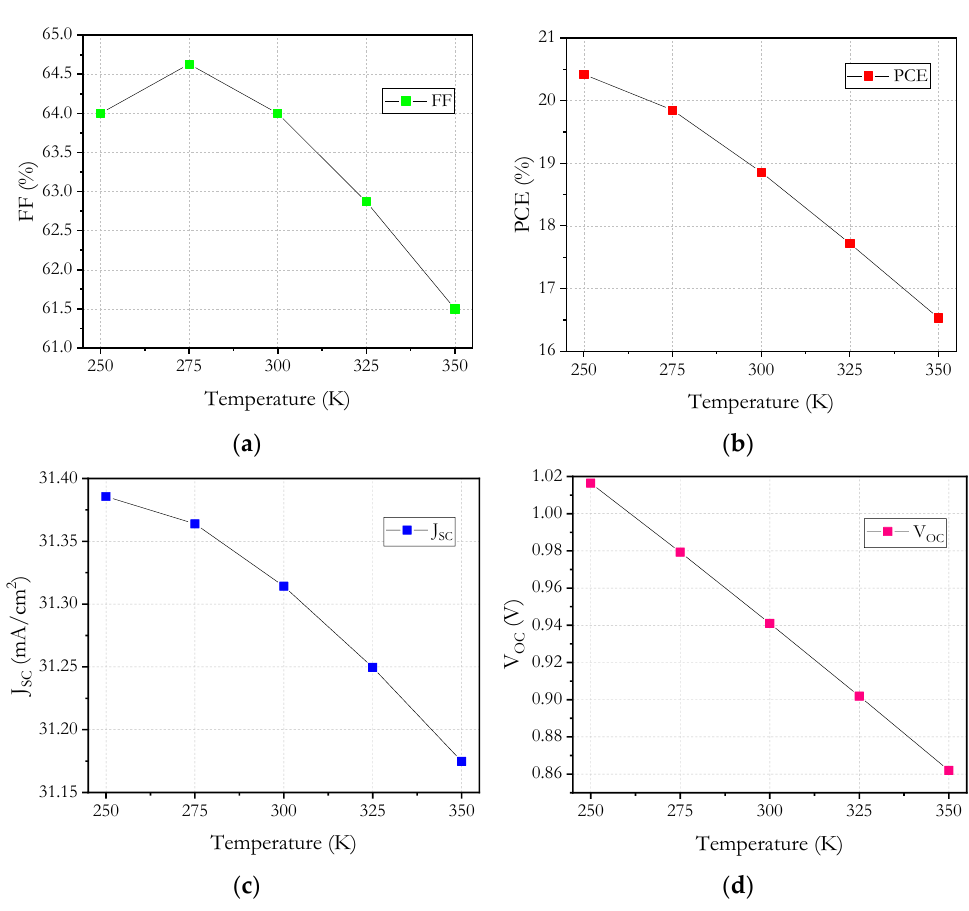
Figure 12. Effect of working temperature versus: ( a ) FF , ( b ) PCE , ( c ) J sc and ( d ) V oc .